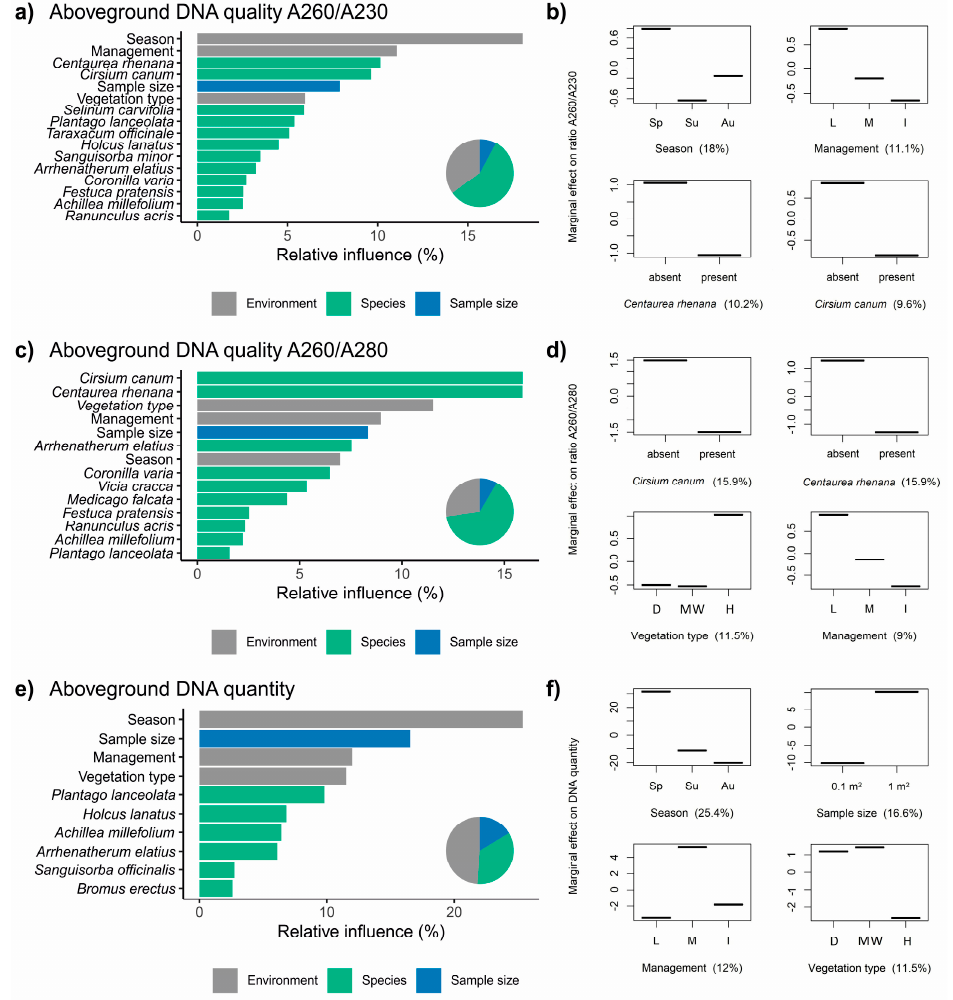
Figure 4. The relative influence (%) and main partial dependence plots showing the marginal rela- tionships between aboveground DNA quality: A260–A230 ( a , b ), A260–A280 ( c , d ), and quantity ( e , f ), and predictors after model simplification. Partial dependence plots show the best four predictors. Pie charts represent overall importance of the predictor categories. The full BRT models for DNA quality and quantity and all predictors are shown in Figures S4–S6. Abbreviations: D—dry grassland, MW— moderately wet grassland, W—wet grassland, Sp—spring, Su—summer, Au—autumn; management: L—low intensity, M—medium intensity, H—high intensity. For more details of predictors see Table